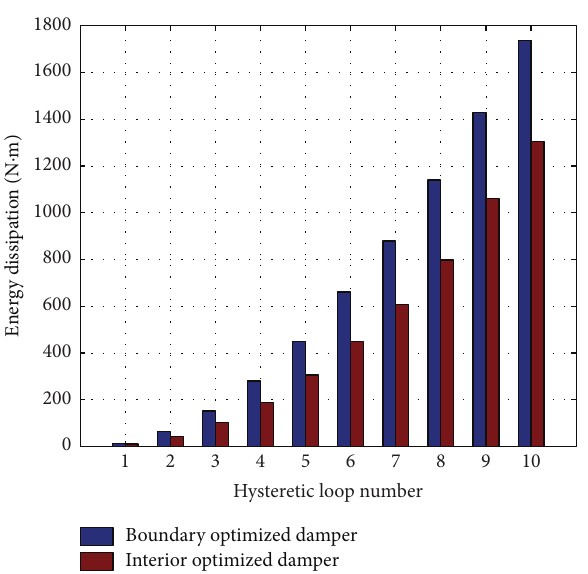
Figure 28: Comparison of energy dissipation of different dampers.